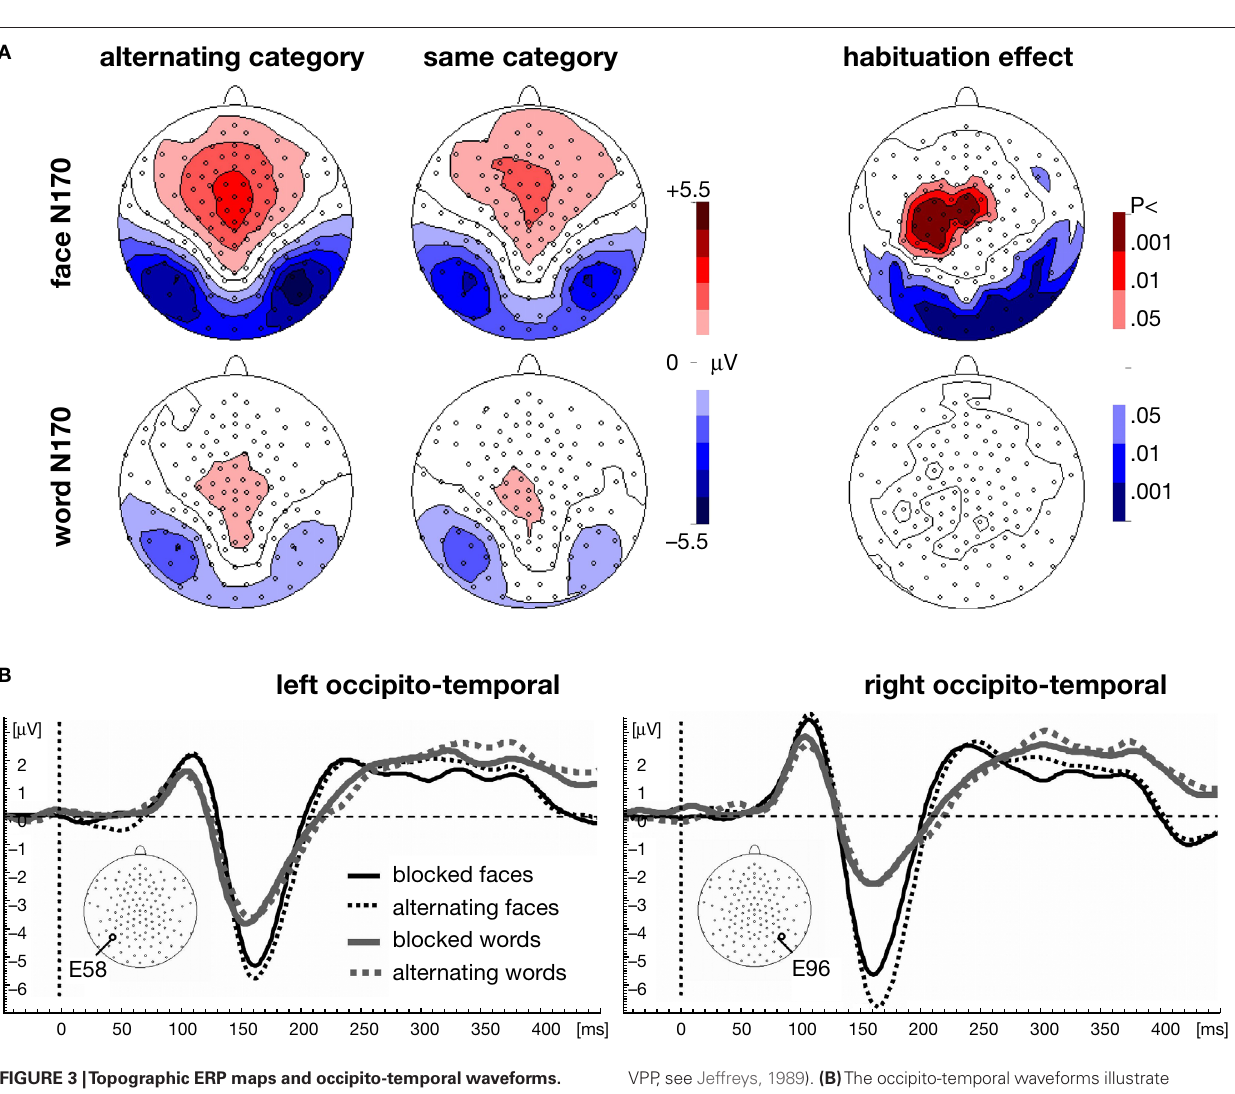
VPP, see Jeffreys, 1989). (B) The occipito-temporal waveforms illustrate the larger N170 for faces (black lines) than for words (gray lines). While the N170 for words was left-lateralized when presented after other words or after faces, the N170 for faces was right-lateralized only for the faces that followed words. Faces that were presented after other faces showed a bilateral N170, suggesting a right-lateralized effect of